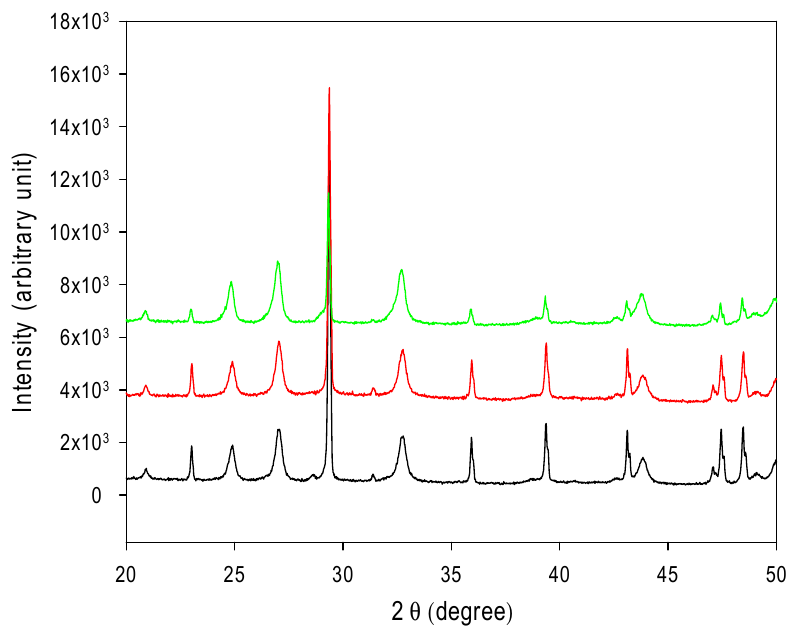
Figure 9. XRD patterns of the precipitated CaCO 3 . C: calcite; V: vaterite. Black: reaction catalyzed by R5-SazCA; red: reaction catalyzed by R5-SazCA-SP; green: negative control without the addition of enzyme.